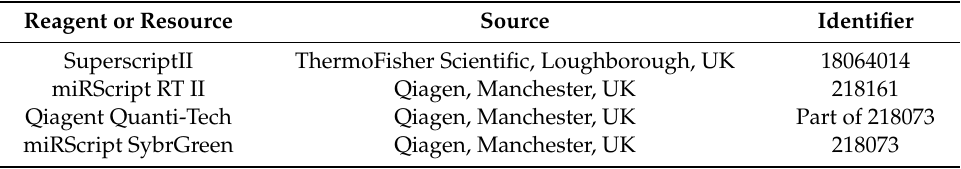
Table A3. Commercial kits used in this